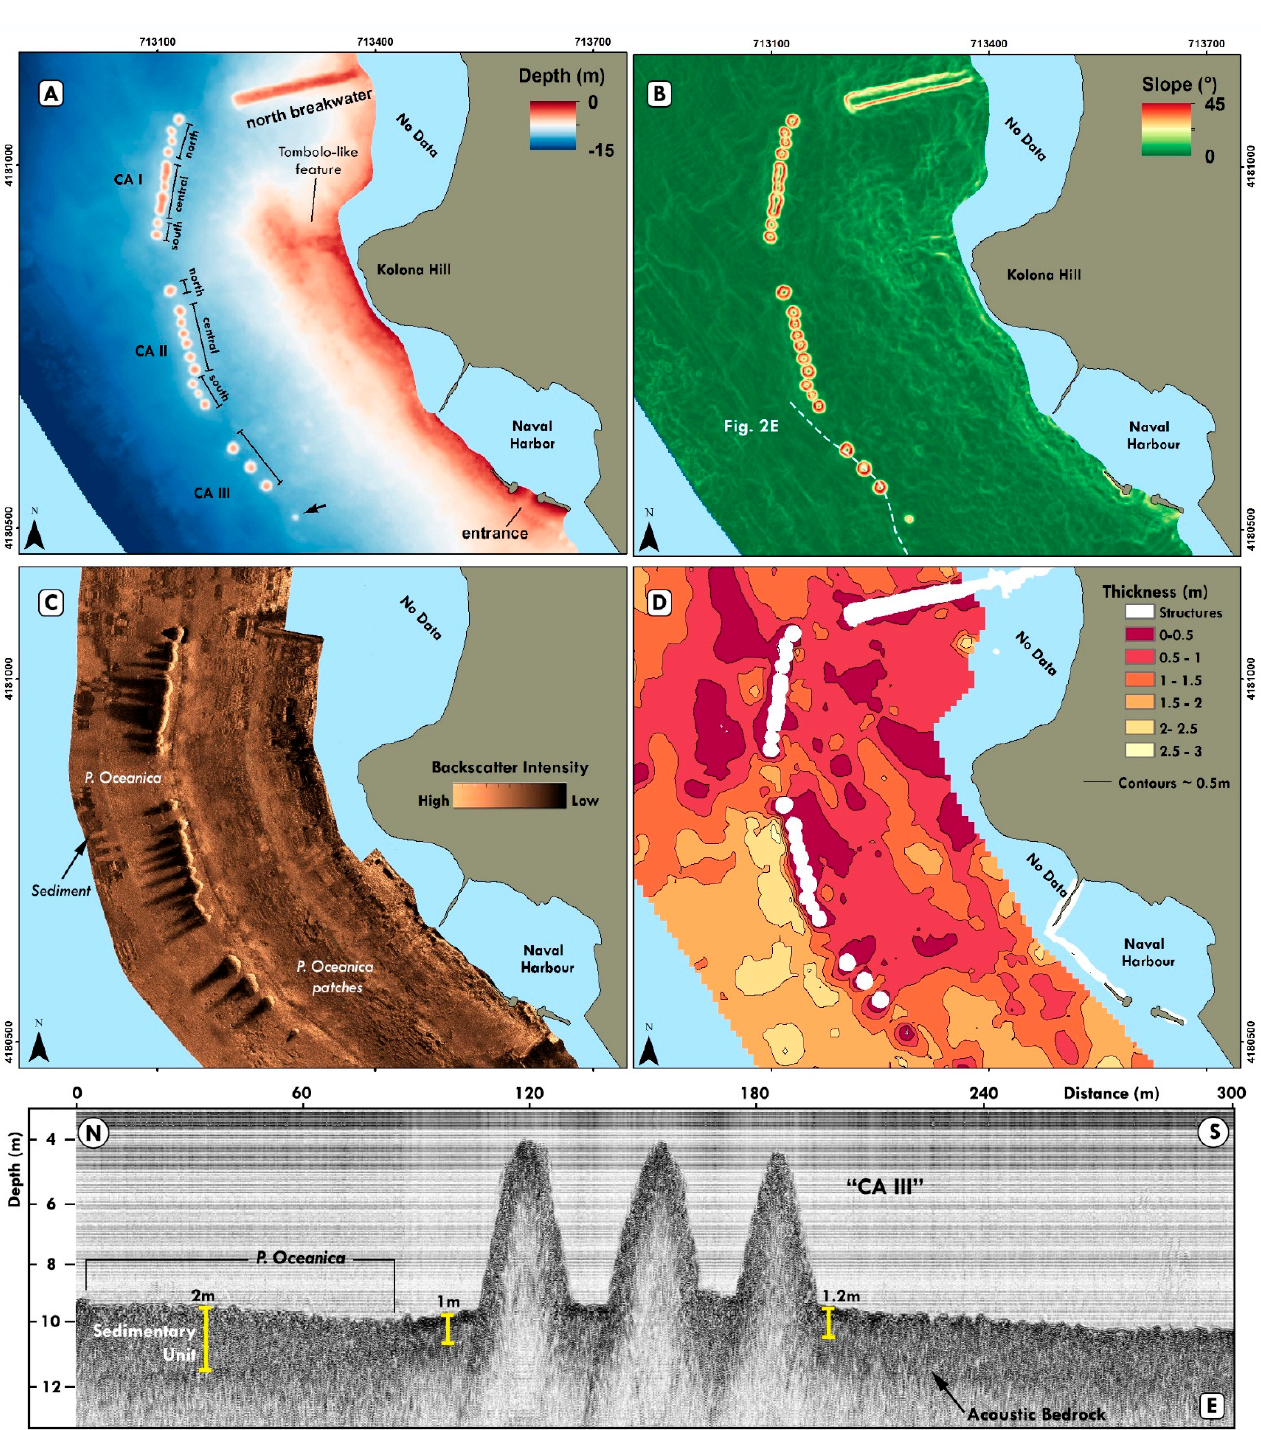
Figure 3. Geophysical data from the northern area (i) as delimited in Figure 1. ( A ) bathymetric map, ( B ) slope map, ( C ) backscatter intensity map, ( D ) sediment thickness map, ( E ) seismic profile (location of the seismic profile is shown in Figure 3C).